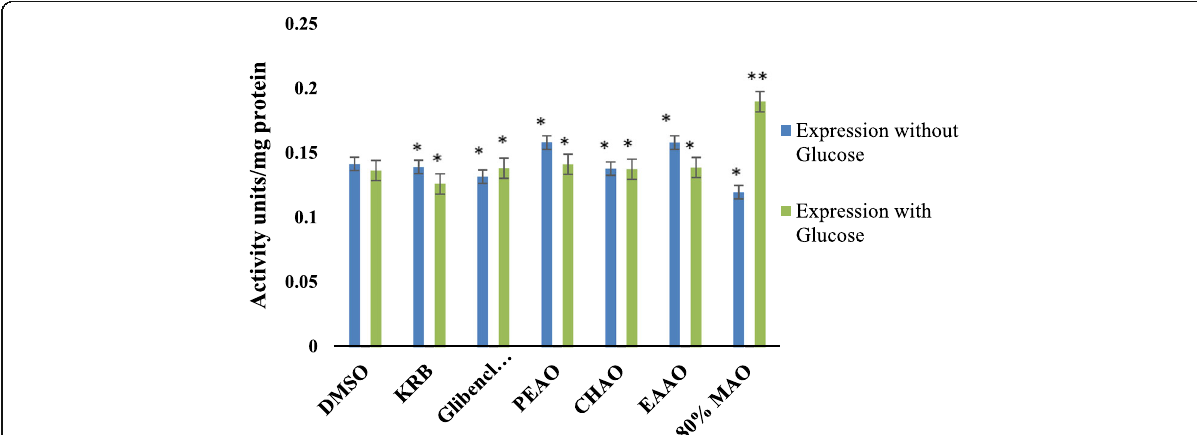
Fig. 3 Effect of four different solvent extracts of A. occidentale roots on Insulin secretion in MIN6 cells in the presence (27mM) and absence of Glucose. * DMSO: Dimethyl sulfoxide, KRB: Krebs Ringers Buffer, PEAO: Petroleum ether extract of A. occidentale, CHAO: Chloroform extract of A. occidentale, EAAO: Ethyl acetate extract of A. occidentale, 80% MAO: 80% Methanol extract of A. occidentale. ‘ * ’ indicates values significantly differ from Control at P ˂ 0.05. ‘ ** ’ indicates values significantly differ from the standard at P ˂